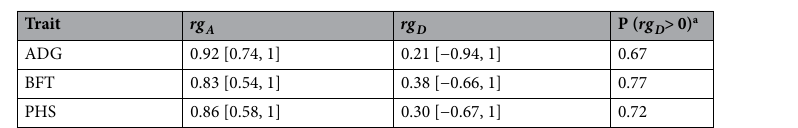
Table 3. Mean [highest posterior density interval at 95%] of the correlation between purebred and crossbred additive ( rg A ) and dominance ( rg D ) genotypic effects estimated in a bivariate model where purebred and crossbred performances are considered different traits. ADG average daily gain, BFT backfat thickness, PHS pH of the semimembranosus muscle. a Probability of a positive dominance genotypic correlation (P ( rg D > 0)).